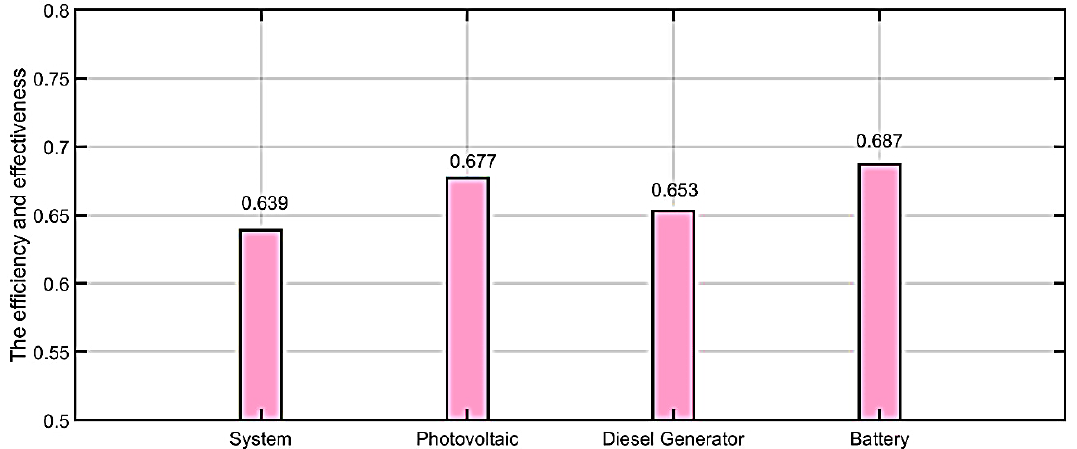
Figure 14. The efficiency and effectiveness without proposed method.